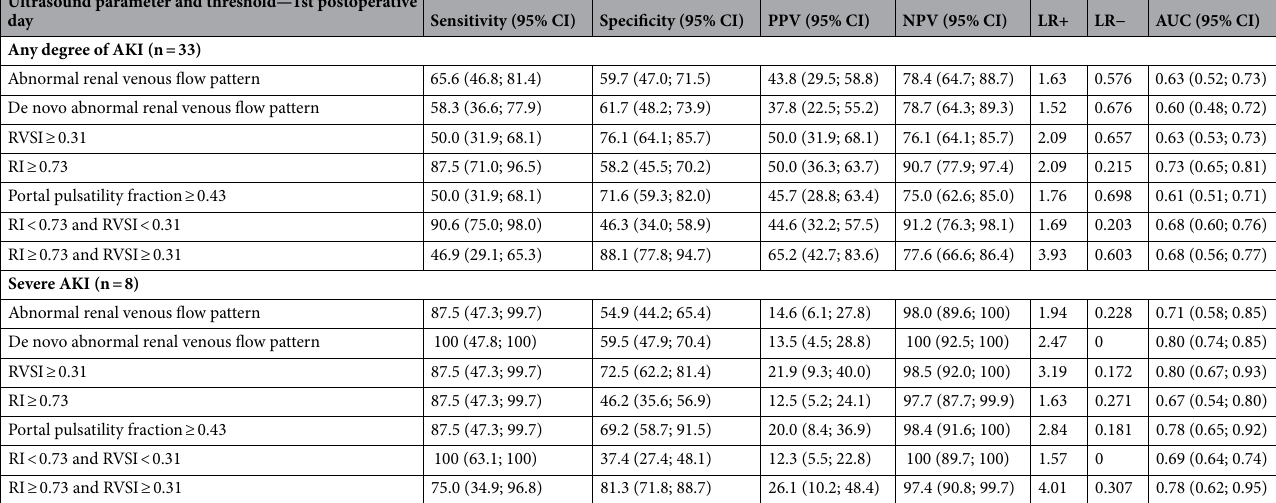
Table 4. Receiver operating characteristics (ROC) of the studied ultrasound indices on the first postoperative day in relation to correctly classifying patients with any degree of AKI (KDIGO stage 1 + 2 + 3) (upper panel) and severe AKI (KDIGO stage 2 + 3) in the lower panel. De novo abnormal renal venous flow pattern was defined as normal pattern preoperatively and abnormal renal venous flow pattern on the first postoperative day. AKI acute kidney injury, AUC area under the curve, CI confidence interval, KDIGO Kidney Disease Improving Global Outcomes, LR + positive likelihood ratio, LR − negative likelihood ratio, NPV